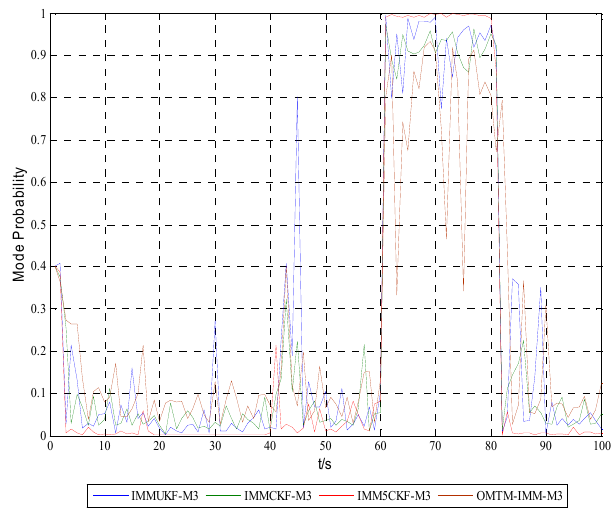
Figure 7. Model probabilities of model 3.